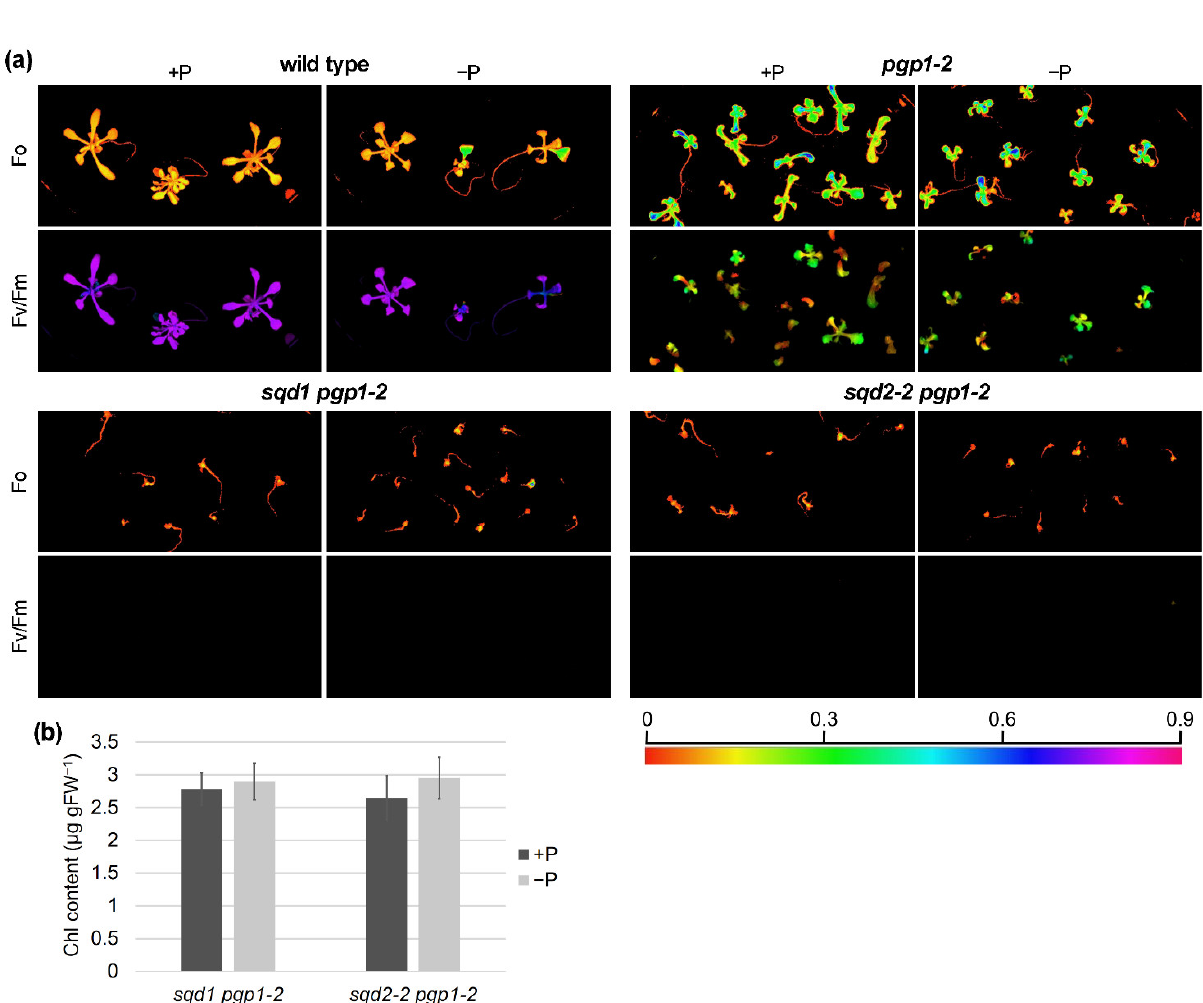
Figure 5. Photosynthetic activity and chlorophyll (Chl) accumulation in the knockout mutants of anionic lipid biosynthesis in plastids. Wild-type seedlings were grown for 7 d and pgp1-2 , sqd1 pgp1-2 , and sqd2-2 pgp1-2 mutants were grown for 14 d under the P-sufficient (+P) condition, followed by the growth under the +P or the P-starved (−P) condition for 7 d. ( a ) Minimum Chl fluorescence (Fo) and maximum PSII quantum yield (Fv/Fm) in seedlings grown under +P or −P conditions. No Fv/Fm signal was observed in the sqd1 pgp1-2 and sqd2-2 pgp1-2 seedlings. ( b ) Chl content in the sqd1 pgp1-2 and sqd2-2 pgp1-2 seedlings grown under +P or −P conditions. Data are means ± SE of 5 seedlings for each experiment. No statistical difference was observed ( p < 0.05, Tukey’s post hoc honestly significant difference test).